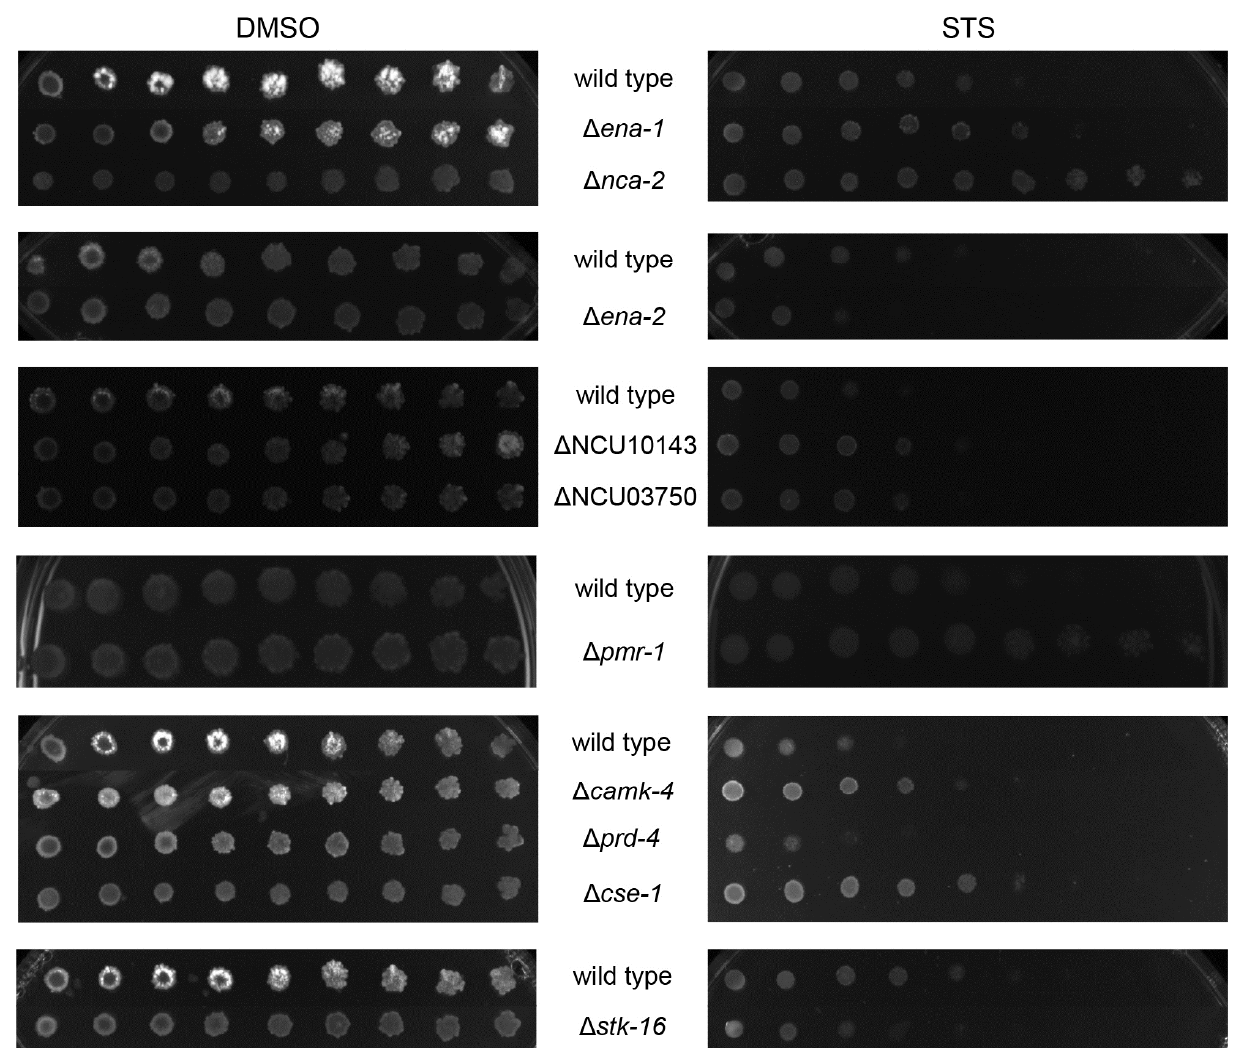
FIGURE 7: Several members of the Ca 2+ handling machinery are involved in the fungal response to staurosporine. Serial dilutions (from left to right) of conidia from the indicated strains were spotted on GFS medium supplemented with 5 μM staurosporine (STS) and incubated for 3